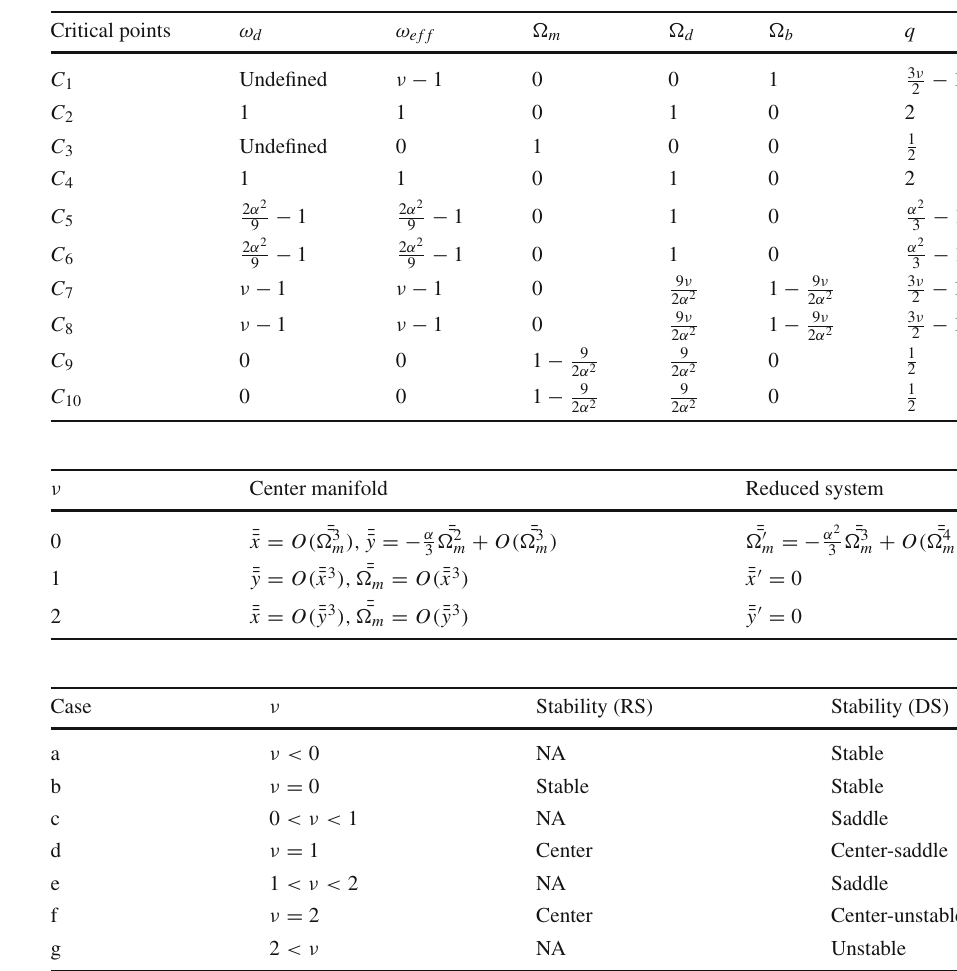
Table 3 C 1 (reduced system)